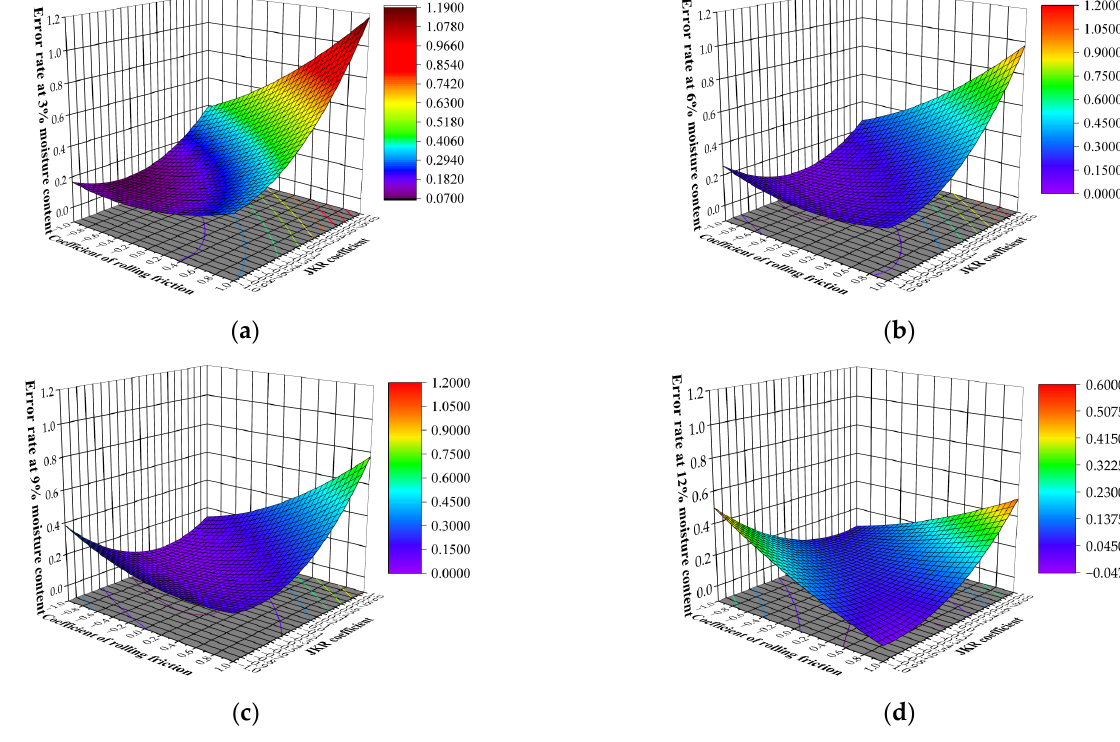
Figure 8. Response surface plots of rolling friction coefficient X 6 and JKR coefficient X 7 for ( a ) 3%, ( b ) 6%, ( c ) 9%, and ( d ) 12% moisture content conditions.